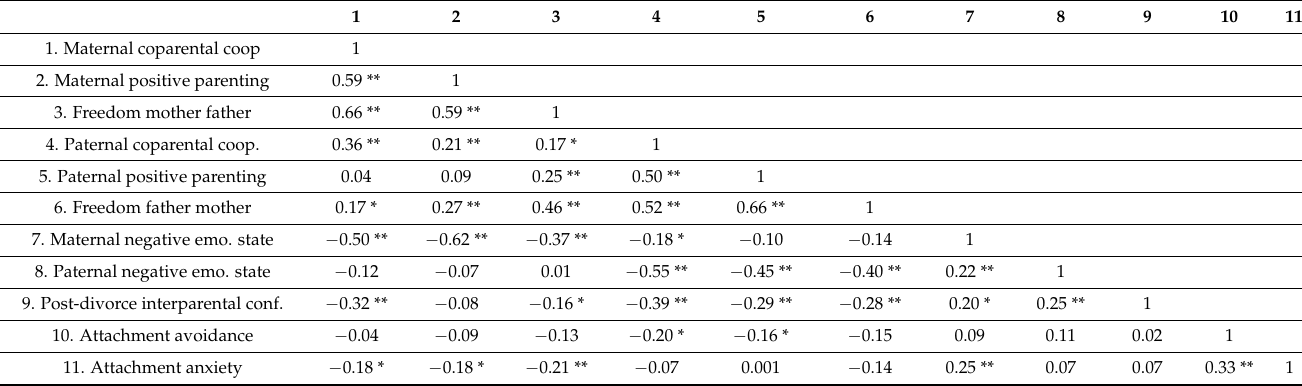
Table 2. Correlations among the study